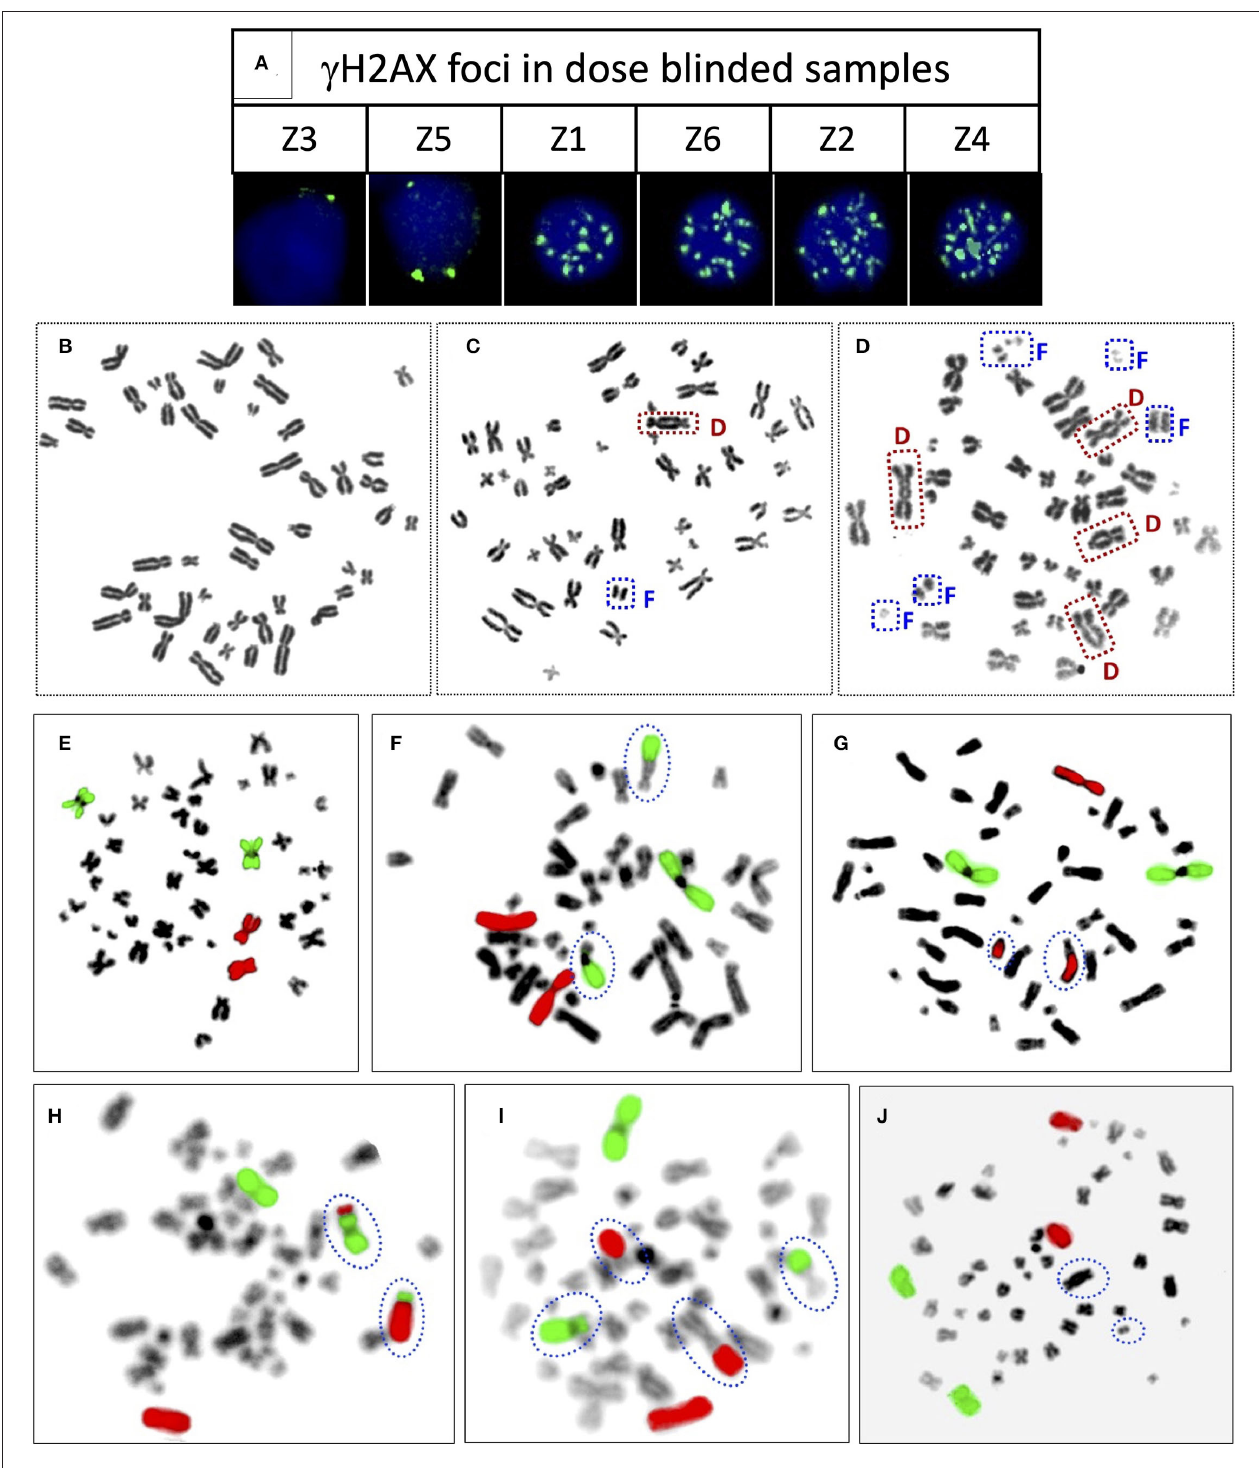
FIGURE 5 | (A) Representative PBLs of dose blinded samples Z3 (1h), Z5 (1h), Z1 (1h), Z6 (1h), Z2 (4h), and Z4 (4h) with their respective number of γ H2AX foci. Representative, Giemsa stained metaphase spreads with (B) no dicentric (C) one dicentric with one fragment (D) three dicentrics and one tricentric with five fragments. Representative metaphase spreads processed for FISH, chromosome pairs 1 and 2 hybridized with whole chromosome paint probes tagged with green and red fluorophores, respectively. Metaphase with (E) no aberration (F) one RT between green and black chromosomes (G) one RT between red and black chromosomes (H) one RT between green and red chromosomes (I) two RT, between green and black, and red and black (J) one dicentric, such metaphases were excluded from the scoring.